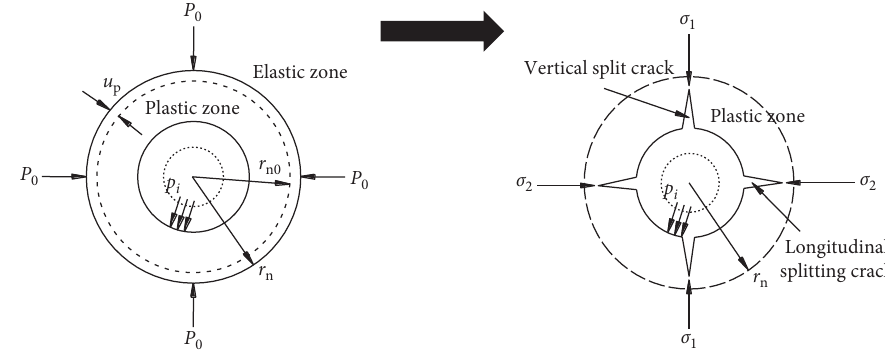
Figure 1: Mechanism of split grouting pile formation.